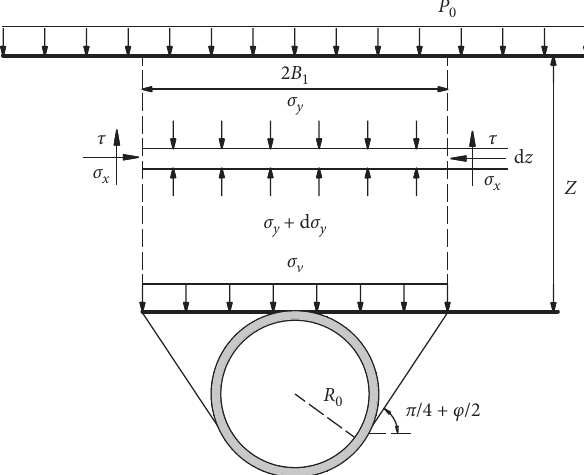
Figure 8: Reduced earth pressure calculated by Terzaghi’s